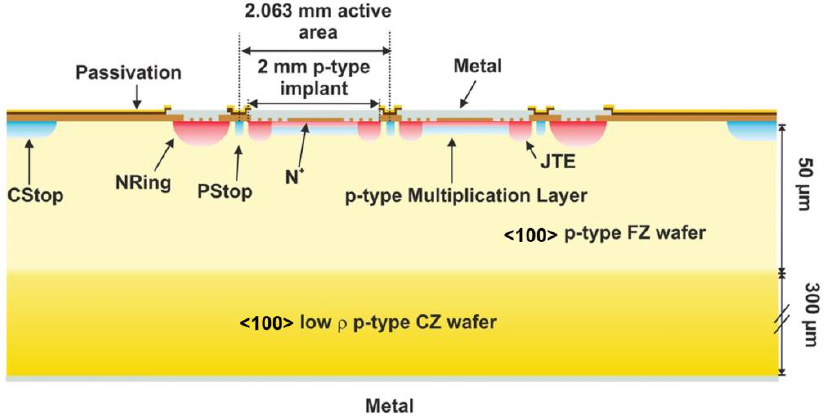
Figure 4. Schematic cross section of the LGAD of 2 × 2 pixels from the CNM production run 10478. The electrical characterization (I-V, C-V) of the detectors was performed at the SSD lab at CERN. From the results, shown in Figure 5, the LGAD main parameters were extracted, these are: V gl ~38 V, V fd ~43 V, V bd ~140 V ( V gl : Gain layer depletion voltage, V fd : Full depletion voltage, 𝑉 𝑏𝑑 : Breakdown voltage ) . The results shown in this paper correspond to a single pixel.